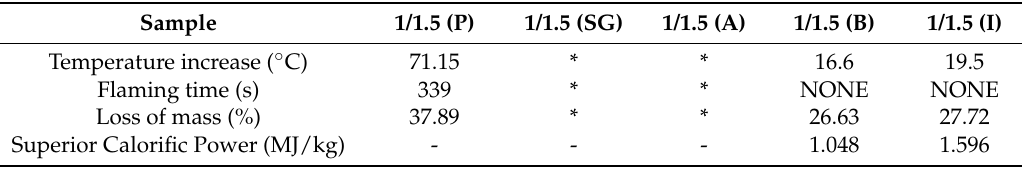
Table 5. Results of non-combustion test and gross heat of combustion test in samples (1/1.5) with different PU